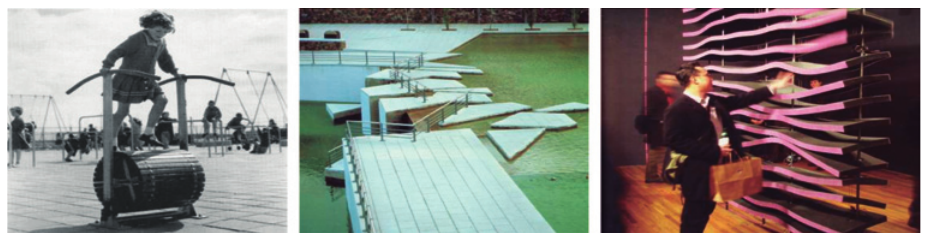
Fig. 22. nARCHITECTS. The Arquitectes. Sabadell, sensor activated Party Wall. Artists Space, New York, 2005 (Kyŏng-wŏn et al. 2006: 137) Note: We only notice the very specific manner environments condition our acts, when we find a place or object that requires an unusual way of being explored or manipulated, and our habits are